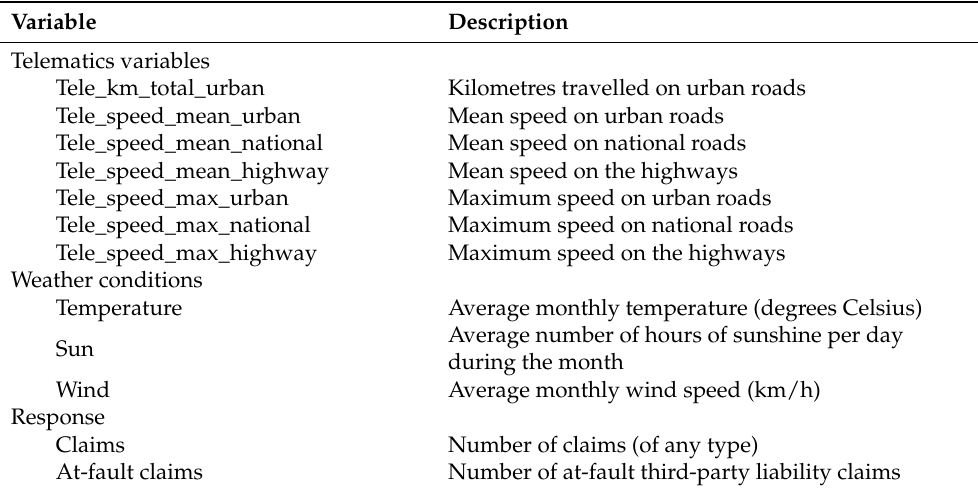
Table 1. Description of the variables finally considered in the analysis. They are all measured from the policyholder’s monthly information. Spanish data set, seven complete months observed in 2018 and